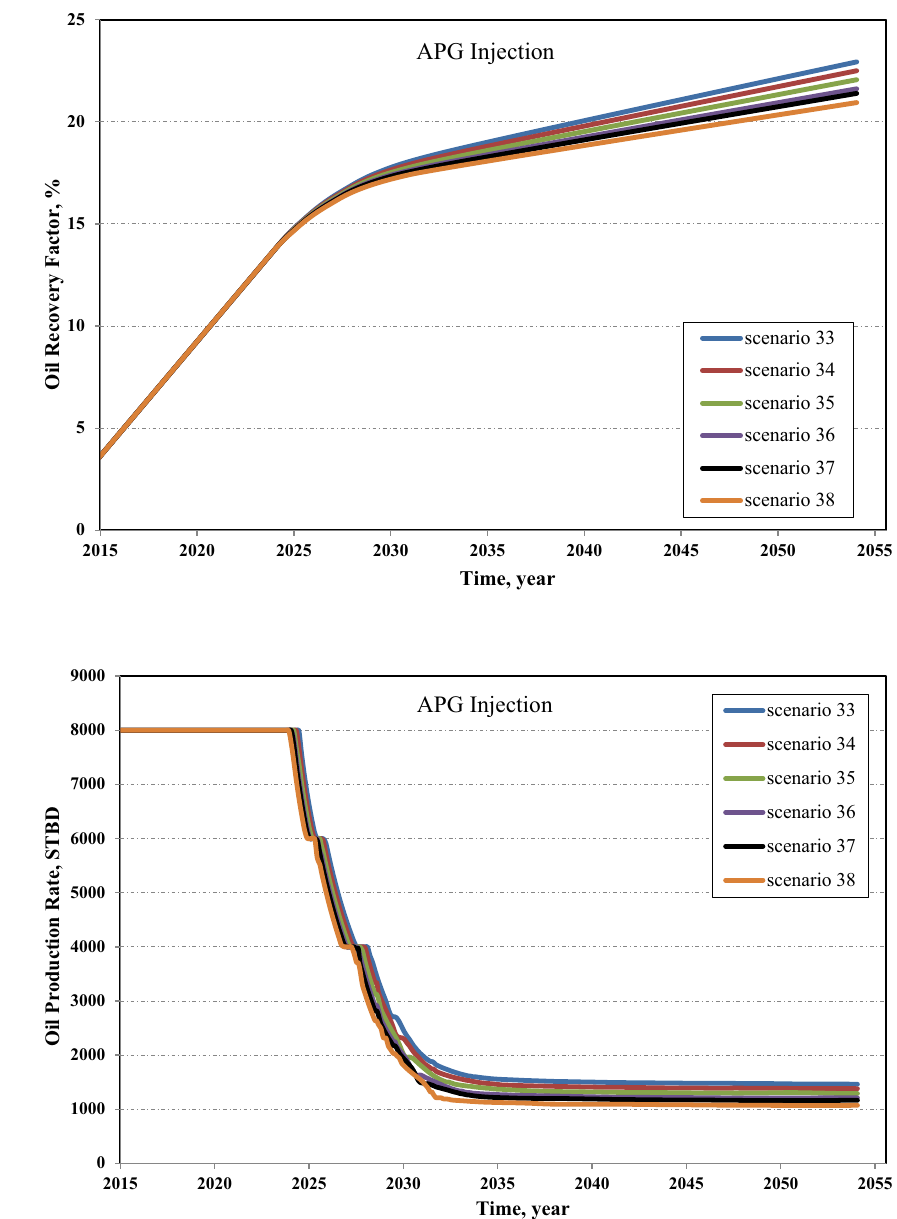
Fig. 13 Oil recovery factor for APG injection into different reservoir layers